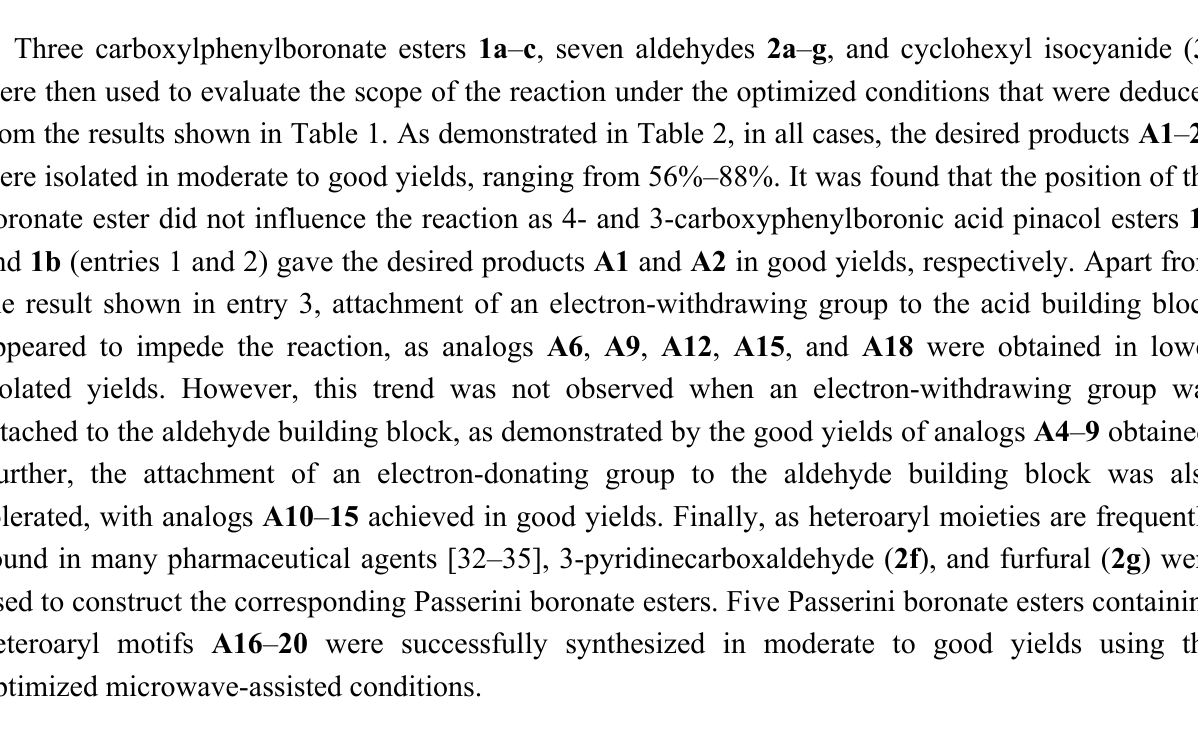
Table 2. Synthesis of Passerini products with boron containing acid building